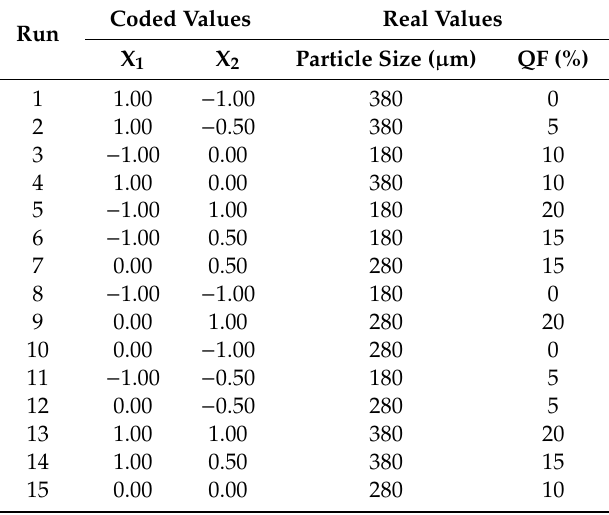
Table 1. Coded and real values of factors used in experimental